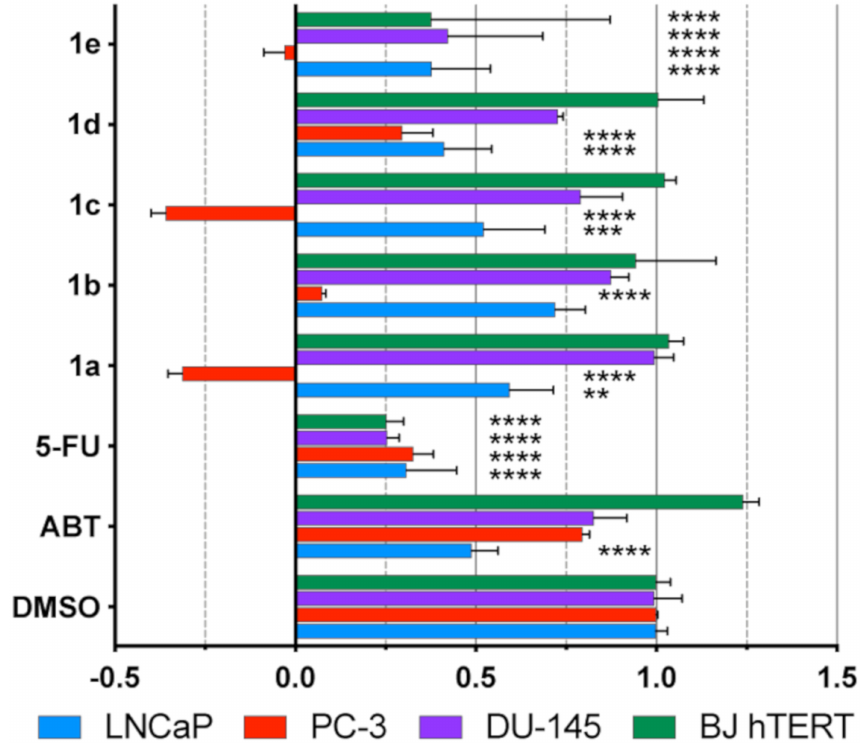
Figure 3. Growth rate inhibition (GR) of 5-fluorouracil (5-FU), Abiraterone (ABT) and compounds 1a - e . All compounds were tested at 10 µ M, with DMSO as a control; The sign of the GR value relates directly to response phenotype: Values between 0 and 1 show partial growth inhibition, a value of 0 equals cytostasis, and values between 0 and − 1 show compounds are cytotoxic. Dunnett’s test used for multiple comparison to a single control. The stars signify an adjusted p value: ** p < 0.01; *** p < 0.001; **** p <